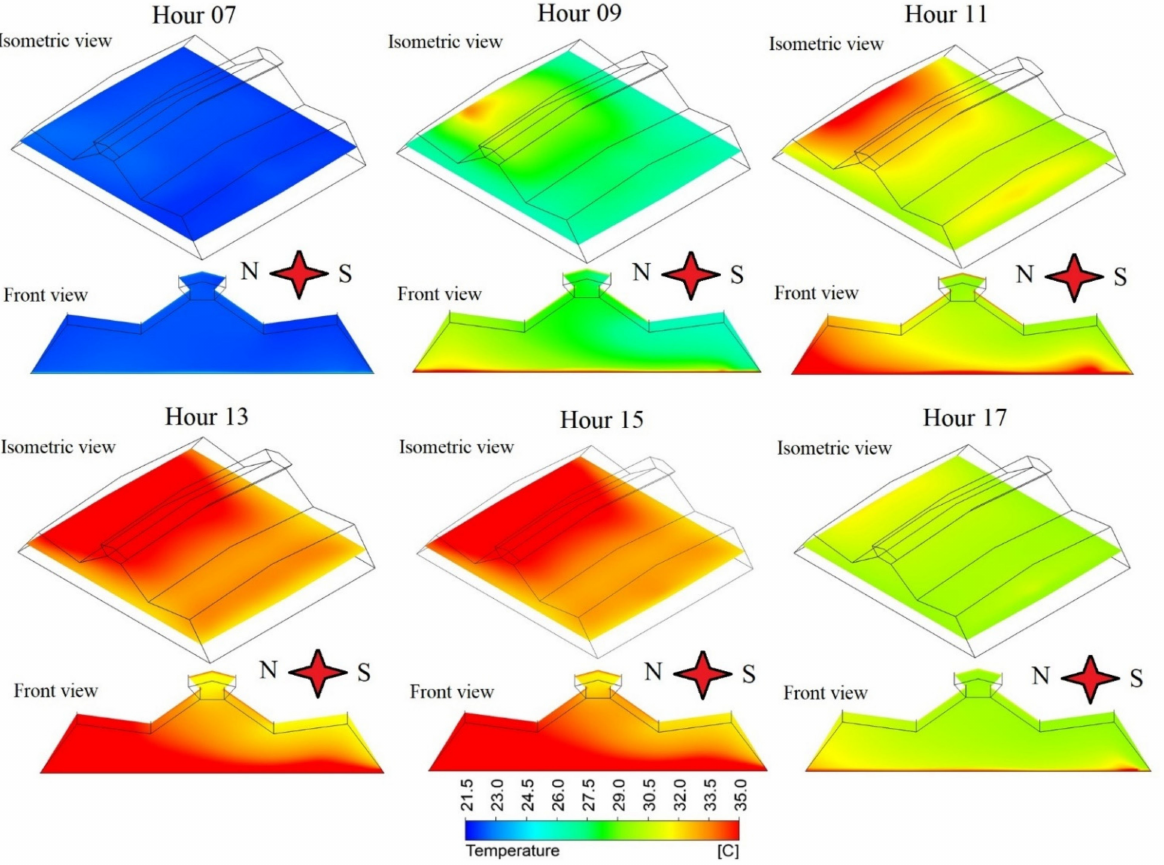
Figure 7. Fields of thermal distribution ( ◦ C) obtained for each evaluated